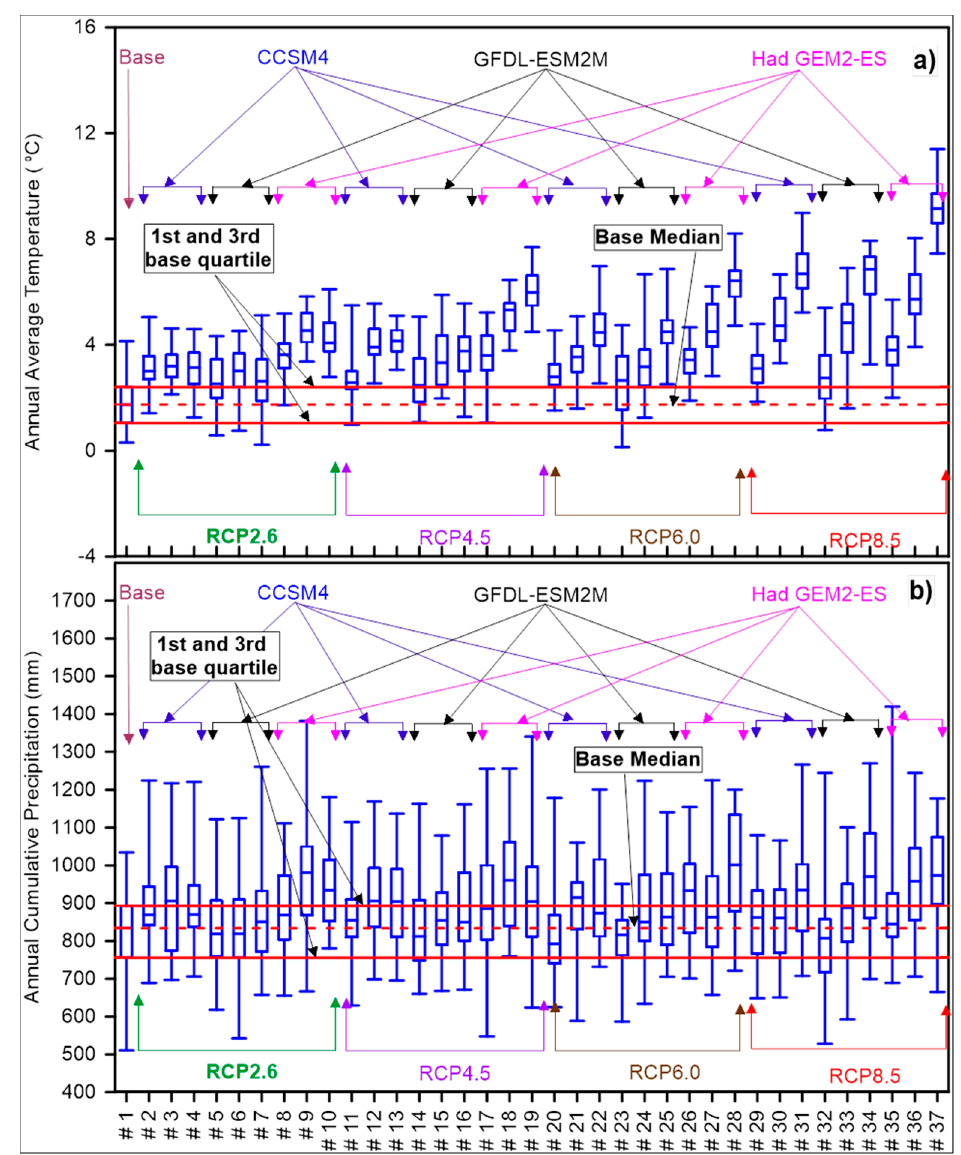
Figure 3. Comparison of ( a ) annual mean temperature and ( b ) annual precipitation for base and future climate ensembles.